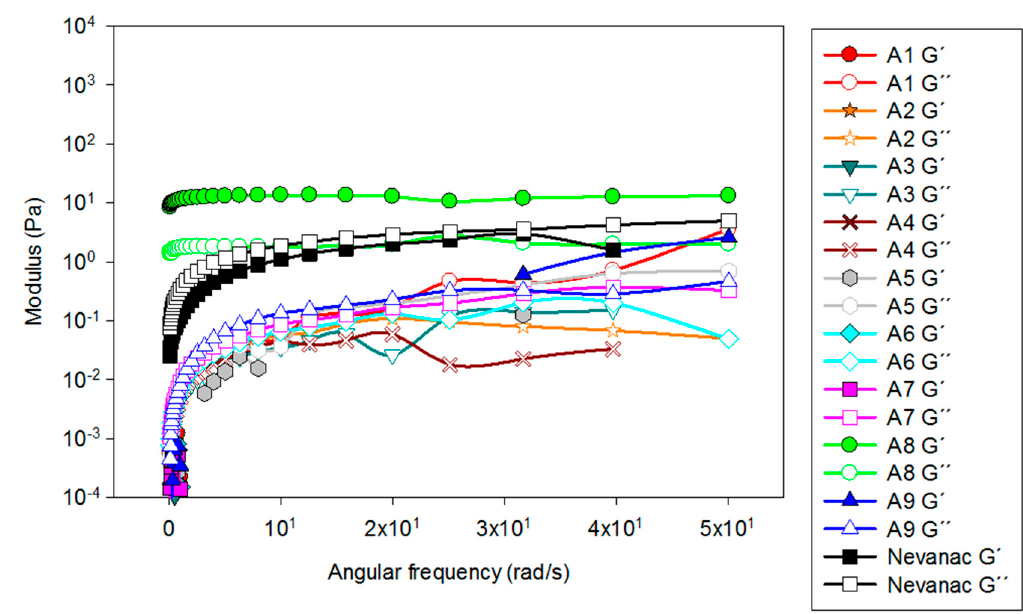
Figure 3. Evolution of storage (G’, solid symbols) and loss (G’’, open symbols) moduli as a function of angular frequency (rad/s).